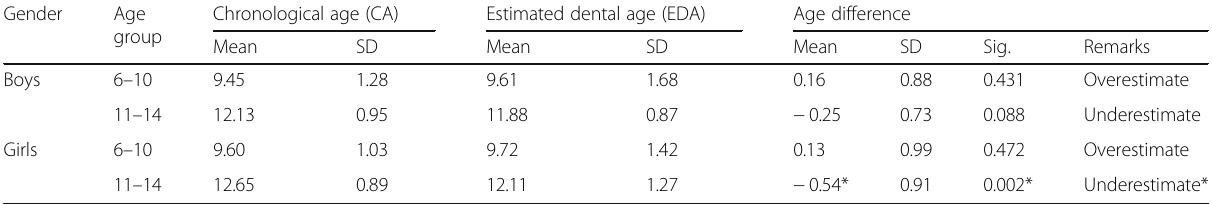
Table 2 Statistical analysis of CA and EDA of the age group in boys and girls (in years) Gender Age